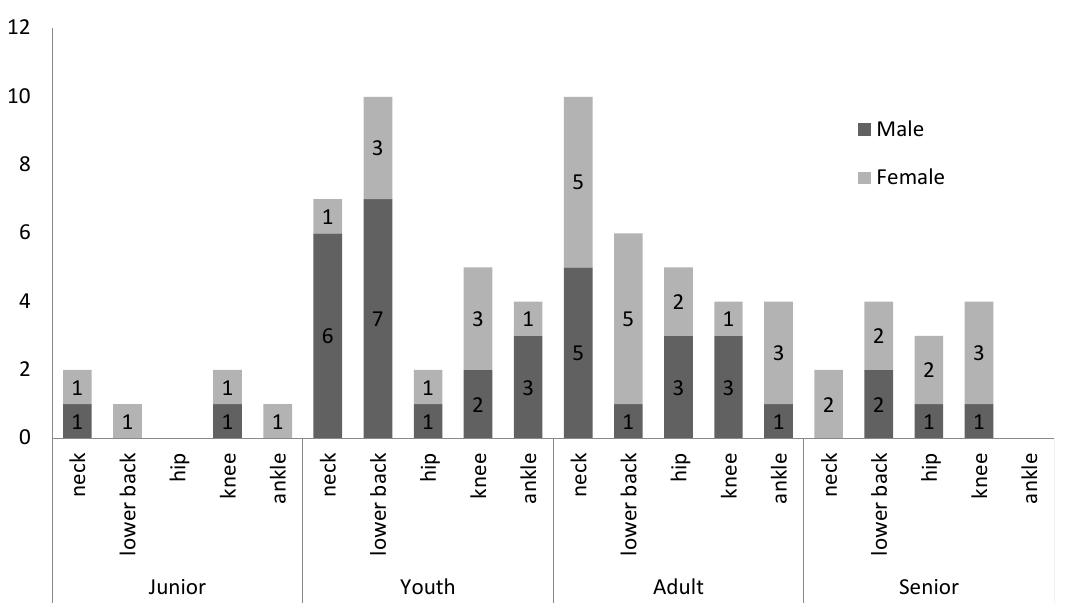
Figure 2. Most common injured body location by gender and age-class.